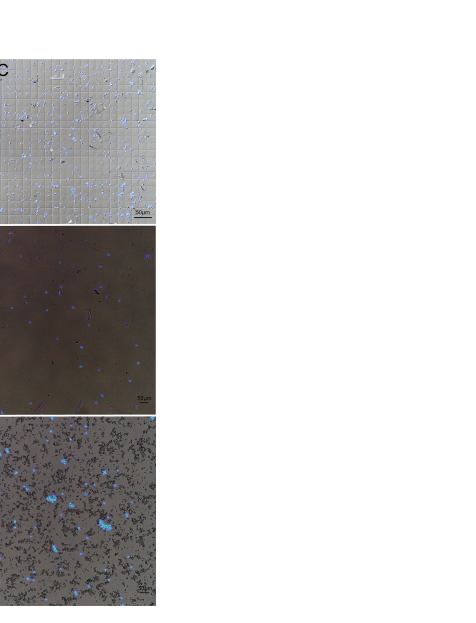
FIGURE 1 Extraction of high quality nuclei in wheat. Nuclei were extracted from 10-day old wheat seedlings by using PP Buffer (A) , Chopping Buffer (B) and D-Sorbitol Buffer (C) . A slightly modi fi ed D-S-0.4 Buffer was used to extracted nuclei from wheat leaf (D) , root (E) , young spike (F) and ovary at 4 d after pollination (G) . The nuclei solution was treated with 0.25 mg/L DAPI and 5 m l solution was taken for checking the quality of nuclei under fl uorescent